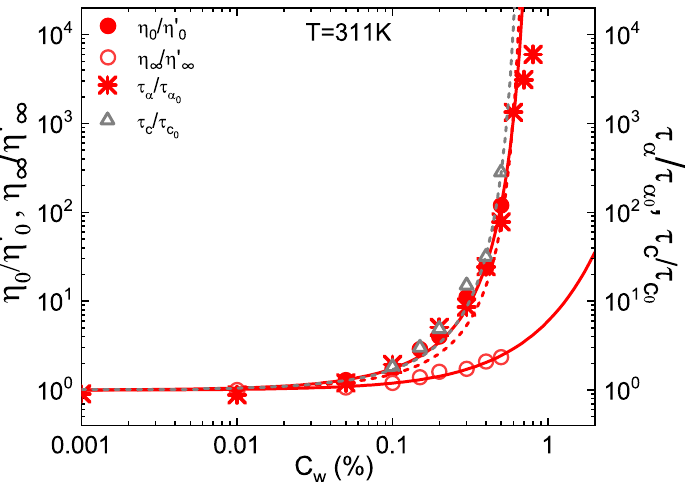
Figure 3. Normalized parameters η 0 , η ∞ and τ C from the Cross fits to the flow curves of Figure 2a, compared with the structural relaxation time τ α measured trough DLS for IPN microgel with PAAc content 24.6% at T = 311K, above the VPT. Lines are fits with the Arrhenius-like model for η ∞ and with the VFT model for η 0 , τ α and τ C